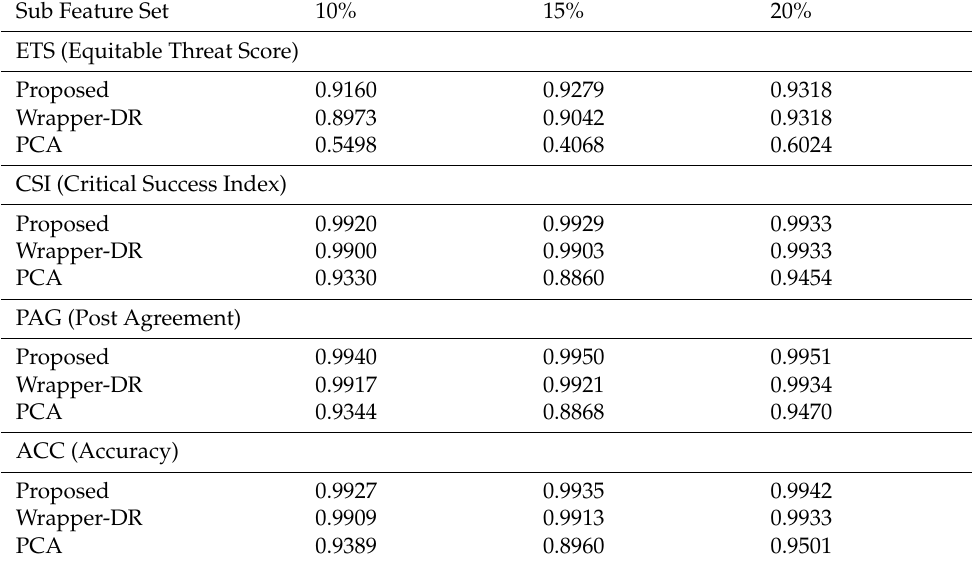
Table 5. Result of